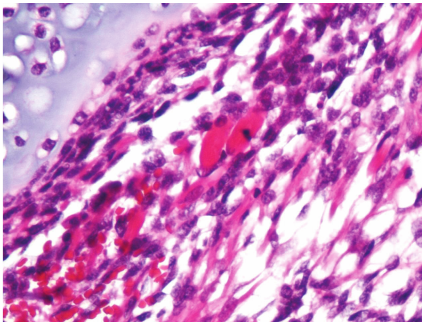
Figure 12: CK19 cytoplasmic staining of cyst lining epithelial cells: ×